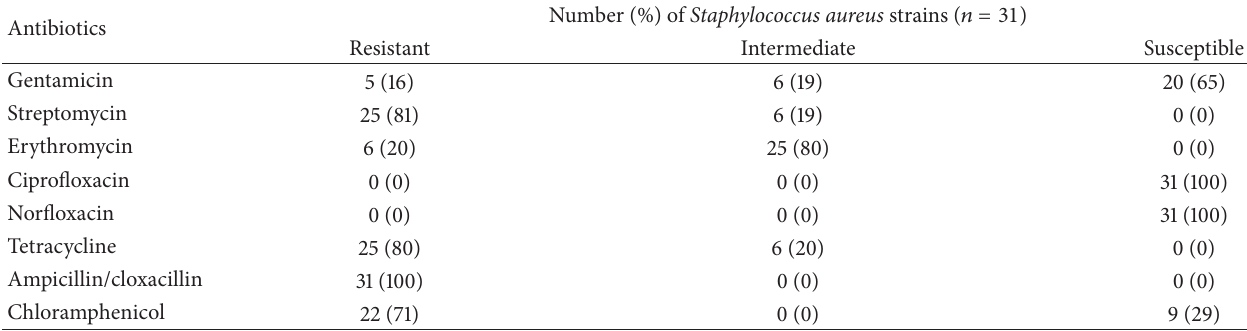
Table 4: Antibiogram of Staphylococcus aureus isolated from food producing animals.